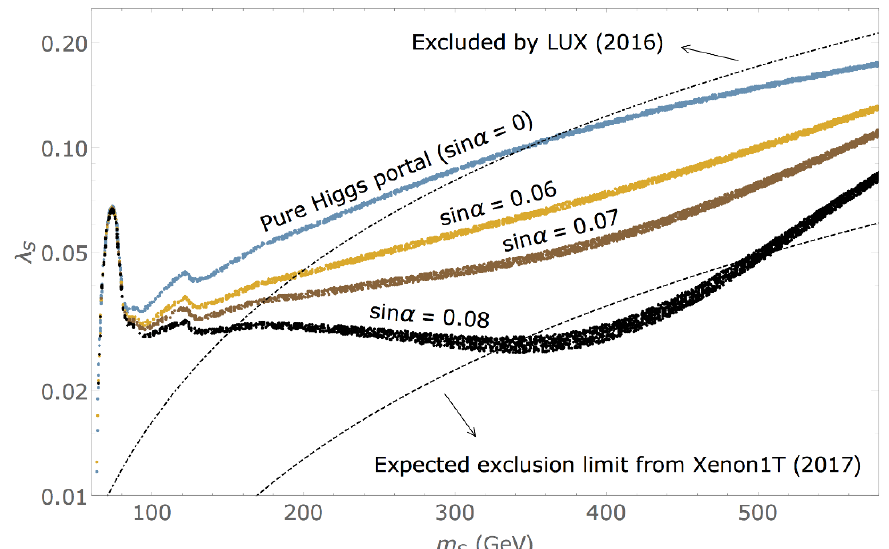
= m = 800 GeV as a benchmark for this (cid:31) ++ (cid:20) ++